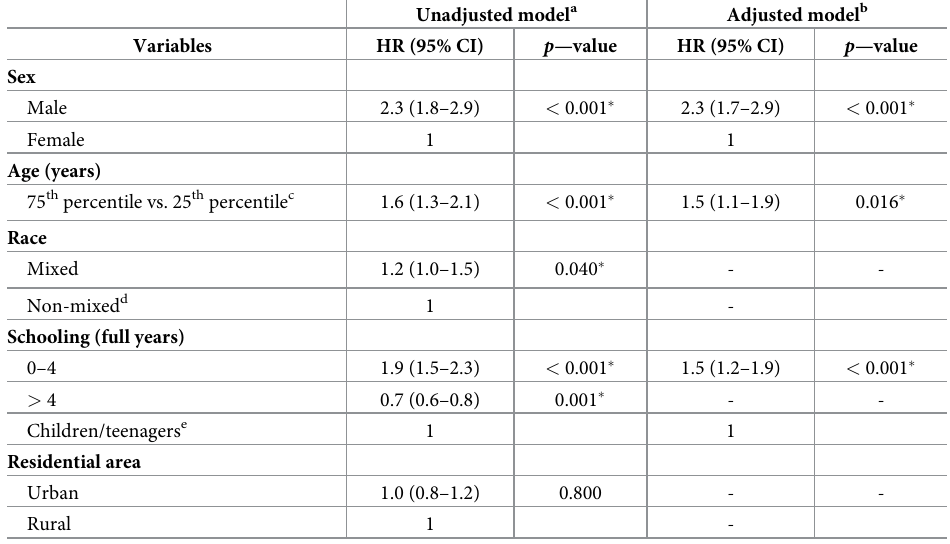
Table 2. Cox proportional hazards models for the time elapsed between the diagnosis of leprosy and cutaneous leishmaniasis in the same individuals. Data from Mato Grosso state, Brazil,